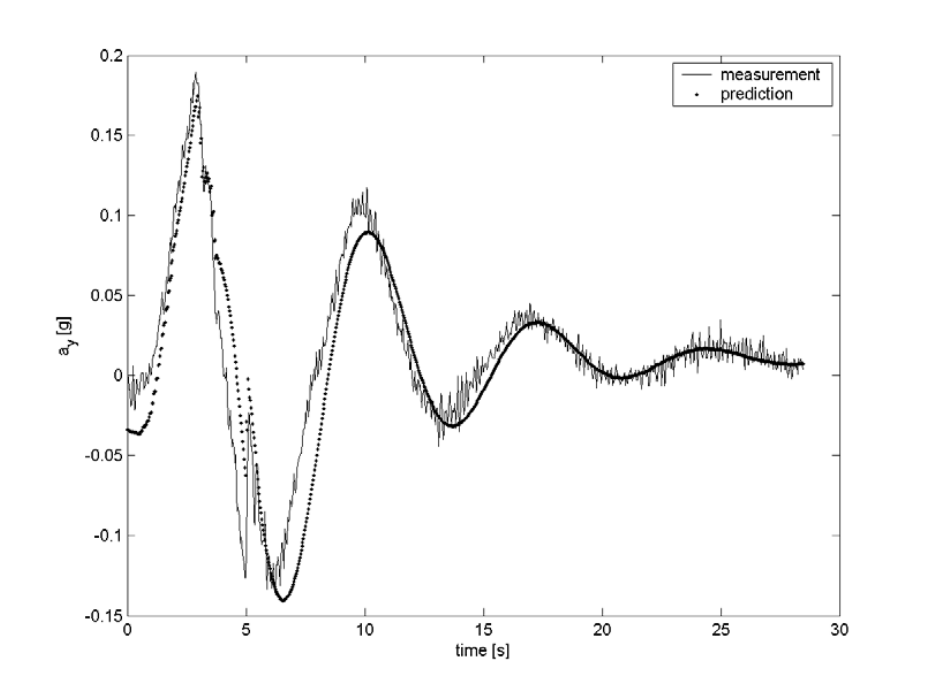
Fig. 12. Measured and estimated acceleration